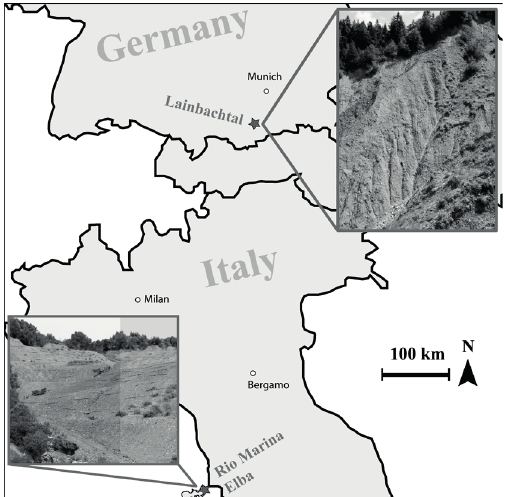
Fig. 1 Location of the two study areas in the Lainbach valley (Bavaria, Gemany) and at the former iron ore mine near Rio Marina on the island of Elba (Tuscany, Italy) in the Tyrrhenian